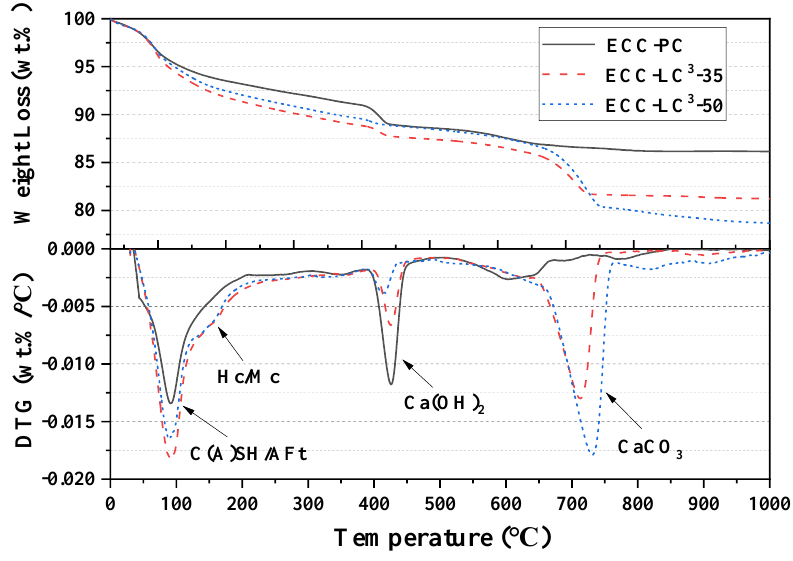
Figure 8. TGA and DTG curves. Table 5. Relative content of Ca(OH) 2 calculated based on DTG curves.